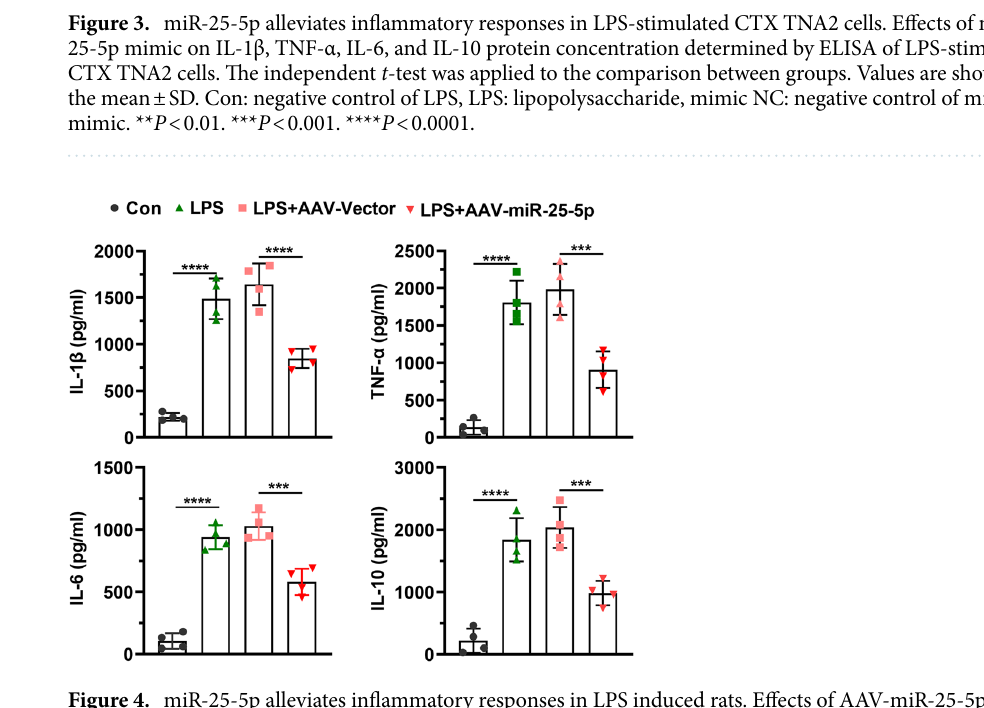
Figure 4. miR-25-5p alleviates inflammatory responses in LPS induced rats. Effects of AAV-miR-25-5p on serum concentrations of IL-1β, TNF-α, IL-6, and IL-10 determined by ELISA in septic rats. The independent t -test was applied to the comparison between groups. Values are shown as the mean ± SD. Con: negative control, LPS: lipopolysaccharide, AAV: adeno-associated virus. *** P < 0.001. **** P <